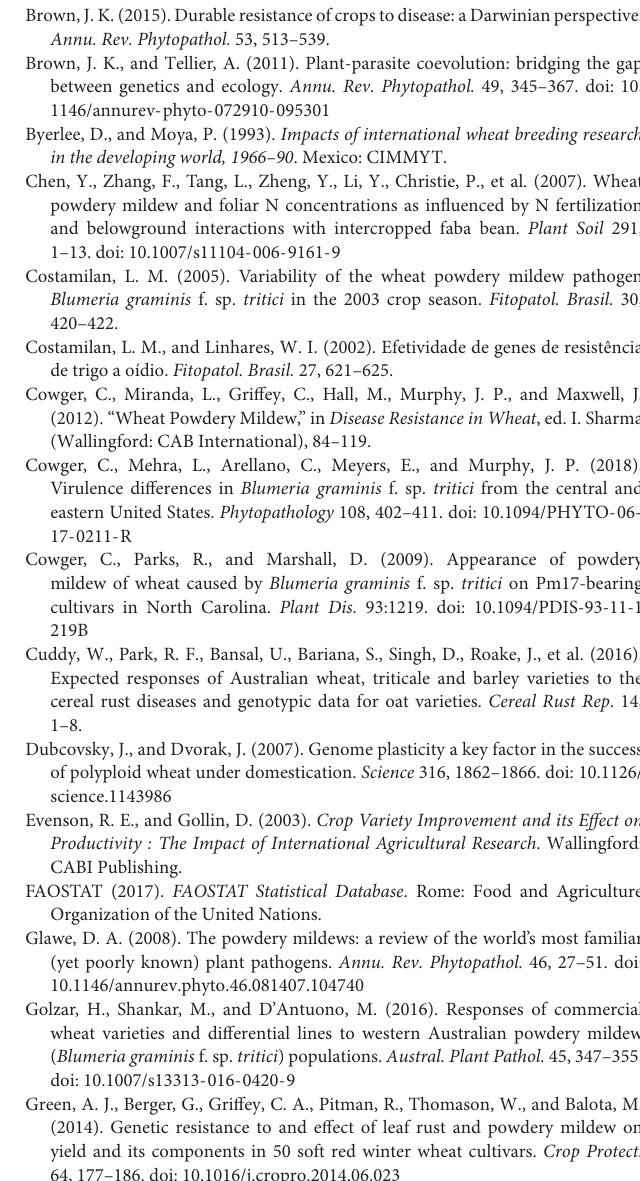
Supplementary Figure 2 | Complexity of virulence to wheat resistance genes among Blumeria graminis f. sp. tritici populations from several countries compared to previously published virulence data for the United States and Egypt, for recently introgressed genes subsetted into (A) four Pm genes that conferred susceptibility to Bgt in detached leaf assays, but were effective against United States Bgt populations in the field d ( Pm25 – NCA6 ), and (B) five Pm genes which were effective both in lab assays and in the field ( NCAG13 – Pm53 ). Virulence complexity was calculated as mean percentage of Pm genes to which isolates were virulent. Within a panel, countries topped by the same letter did not have significantly different virulence complexities ( p < 0.05). Within each box, medians are indicated by lines and means of virulence complexity by crosses. v Abdelrhim et al. (2018). w Turkey/Black Sea region: Isolates from Russian locations Krasnodar and Rostov were grouped with those from Turkey (refer to Table 1 ). x Western Siberia region: Isolates from Karabalyk, Kazakhstan were grouped with those from Russia (refer to Table 1 ). y Cowger et al. (2018). z Genes Pm25 – NCA6 were effective in the field against a natural United States Bgt population (Cowger et al., 2018).